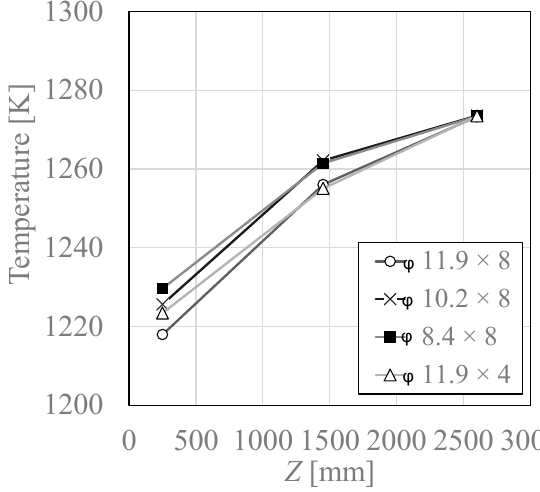
Figure 9. Temperature distribution when the temperature at the point Z = 2600 mm is 1273 K and E H2 = 100%. Input = 174 kW, λ = 1.2, P = +15 Pa.